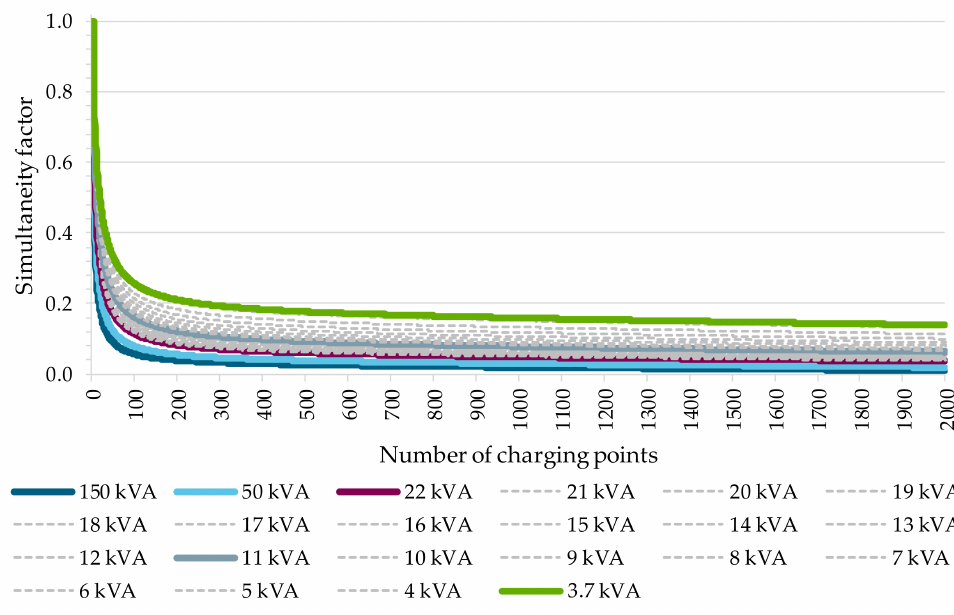
Figure 6. Simultaneity factors for electromobility based on